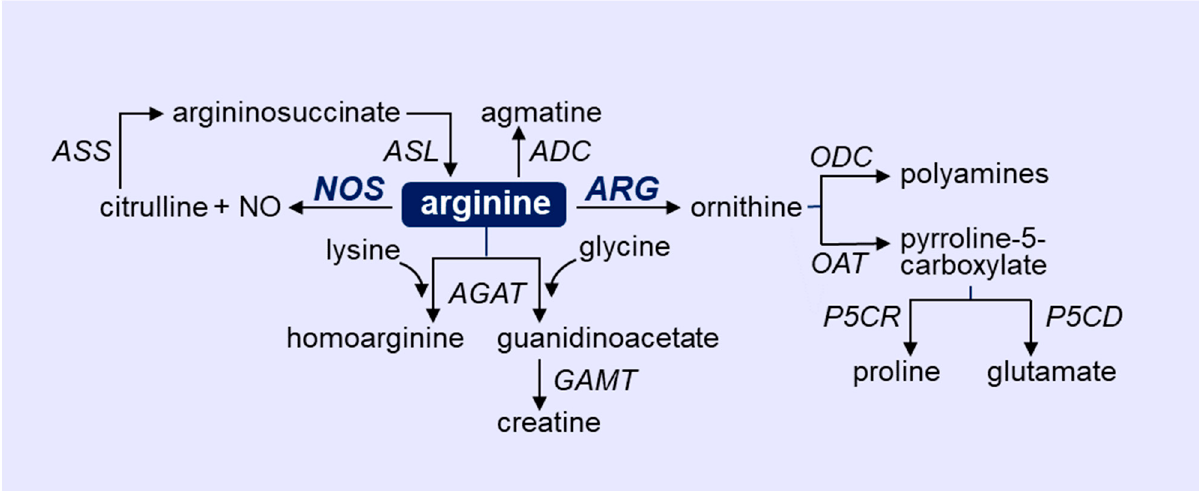
Figure 1. Outline of arginine metabolism via four distinct enzymatic pathways. Arginine catabolism